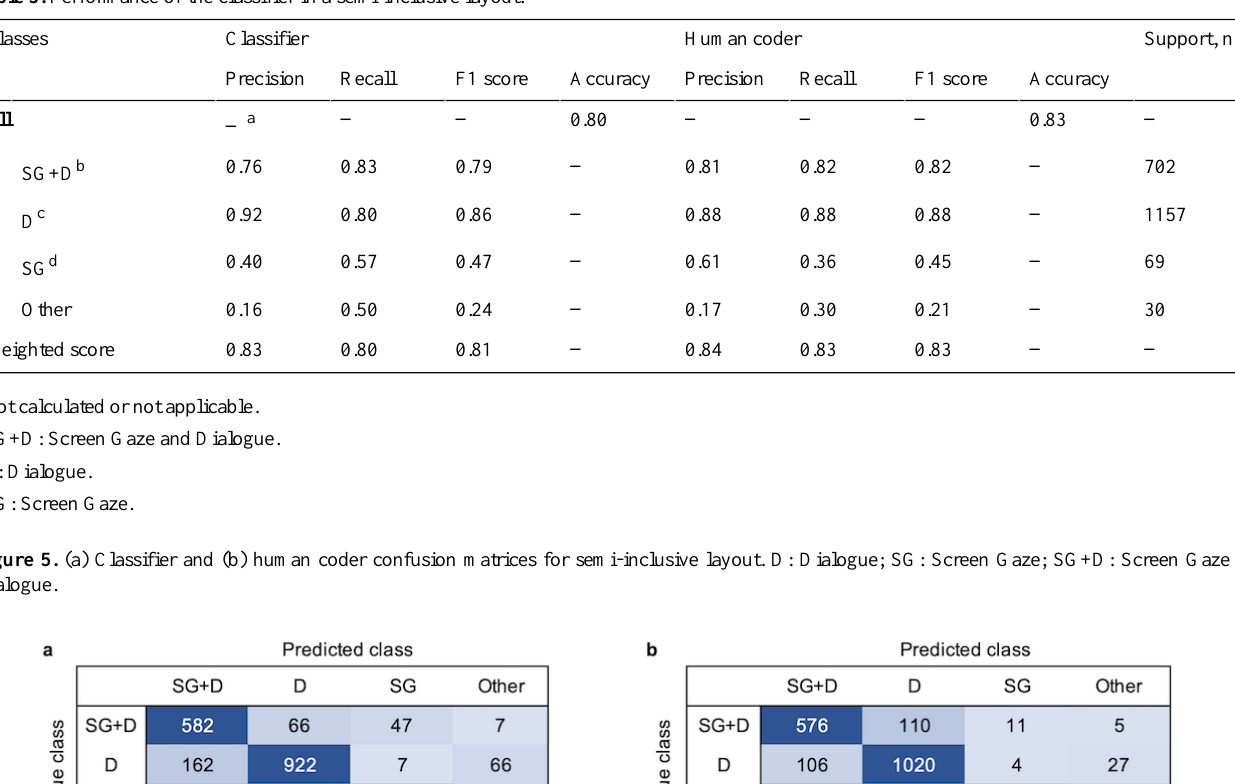
Table 3. Performance of the classifier in a semi-inclusive layout.